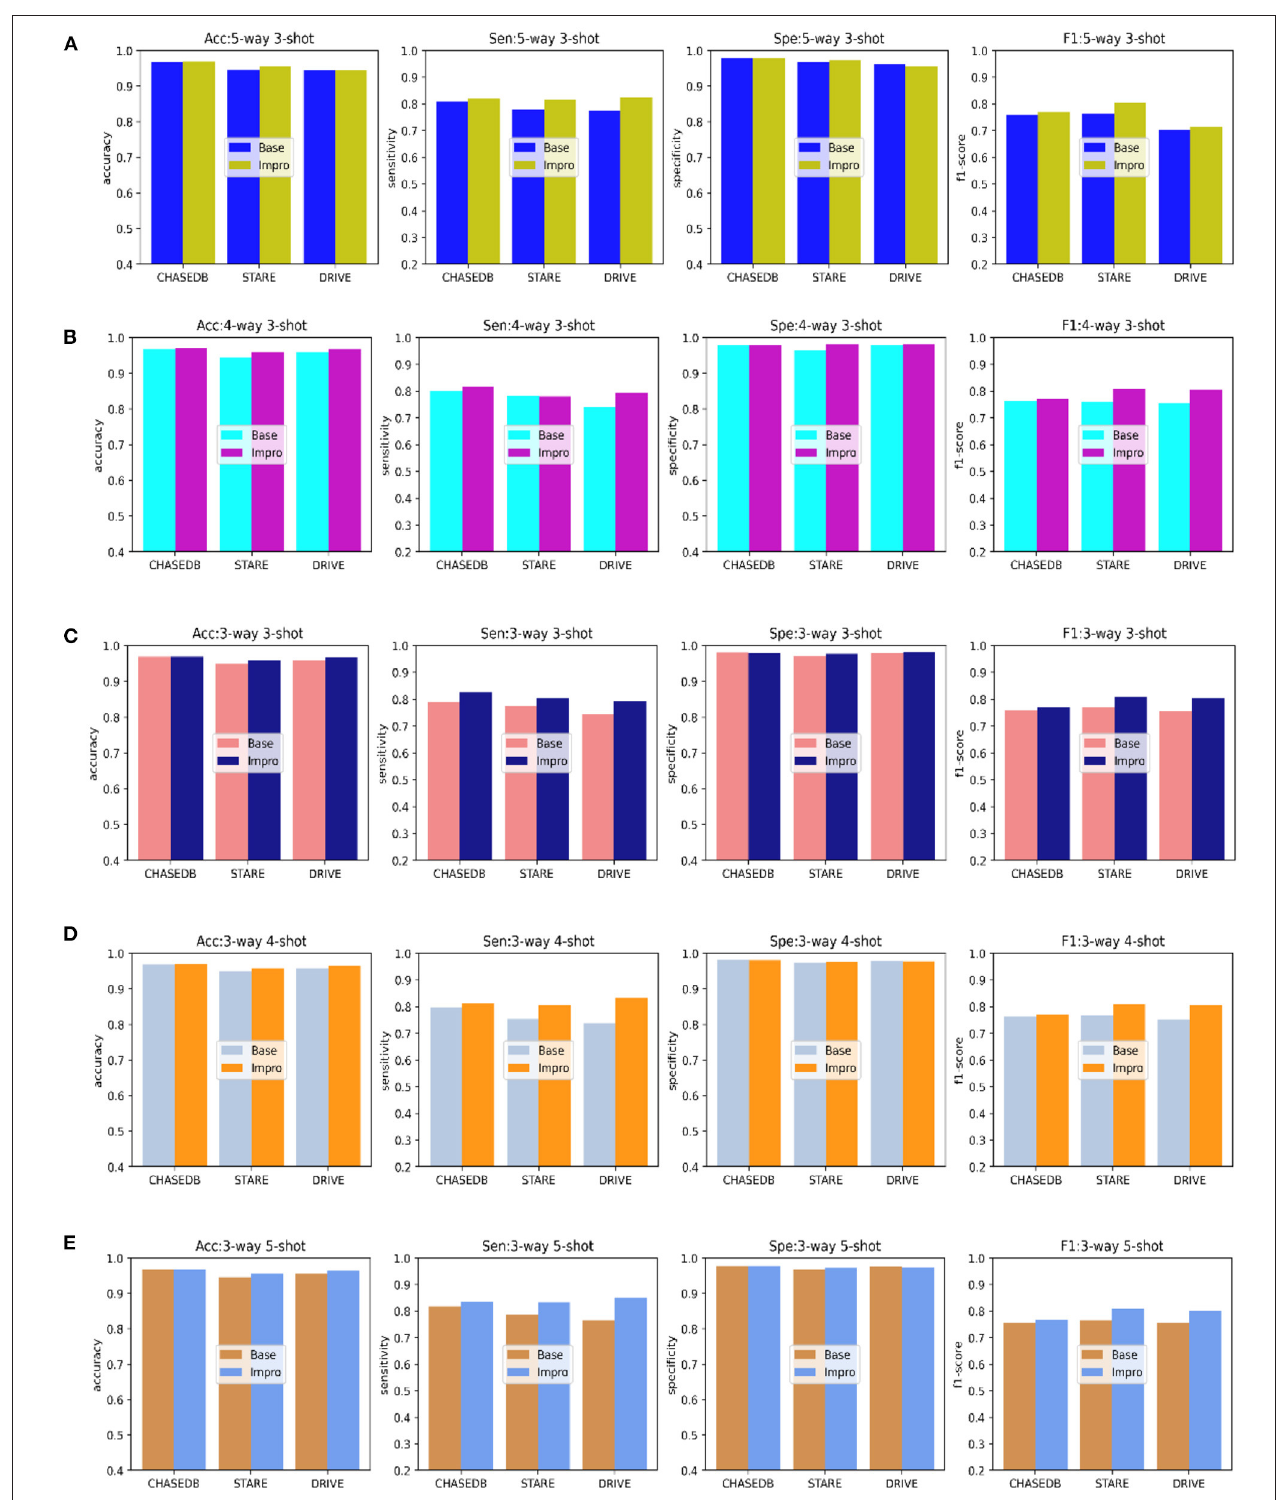
FIGURE 8 | Comparison of the baseline and upgraded models based on the sensitivity, specificity, accuracy, and f1-score: (A) 5-way 3-shot; (B) 4-way 3-; (C) 3-way 3-shot; (D) 3-way 4-shot; and (E) 3-way 5-shot.